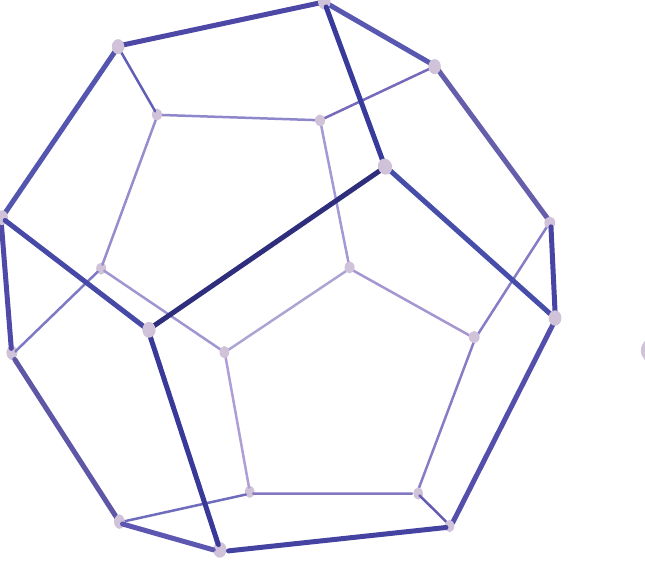
Figure 4: The regular dodecahedron.